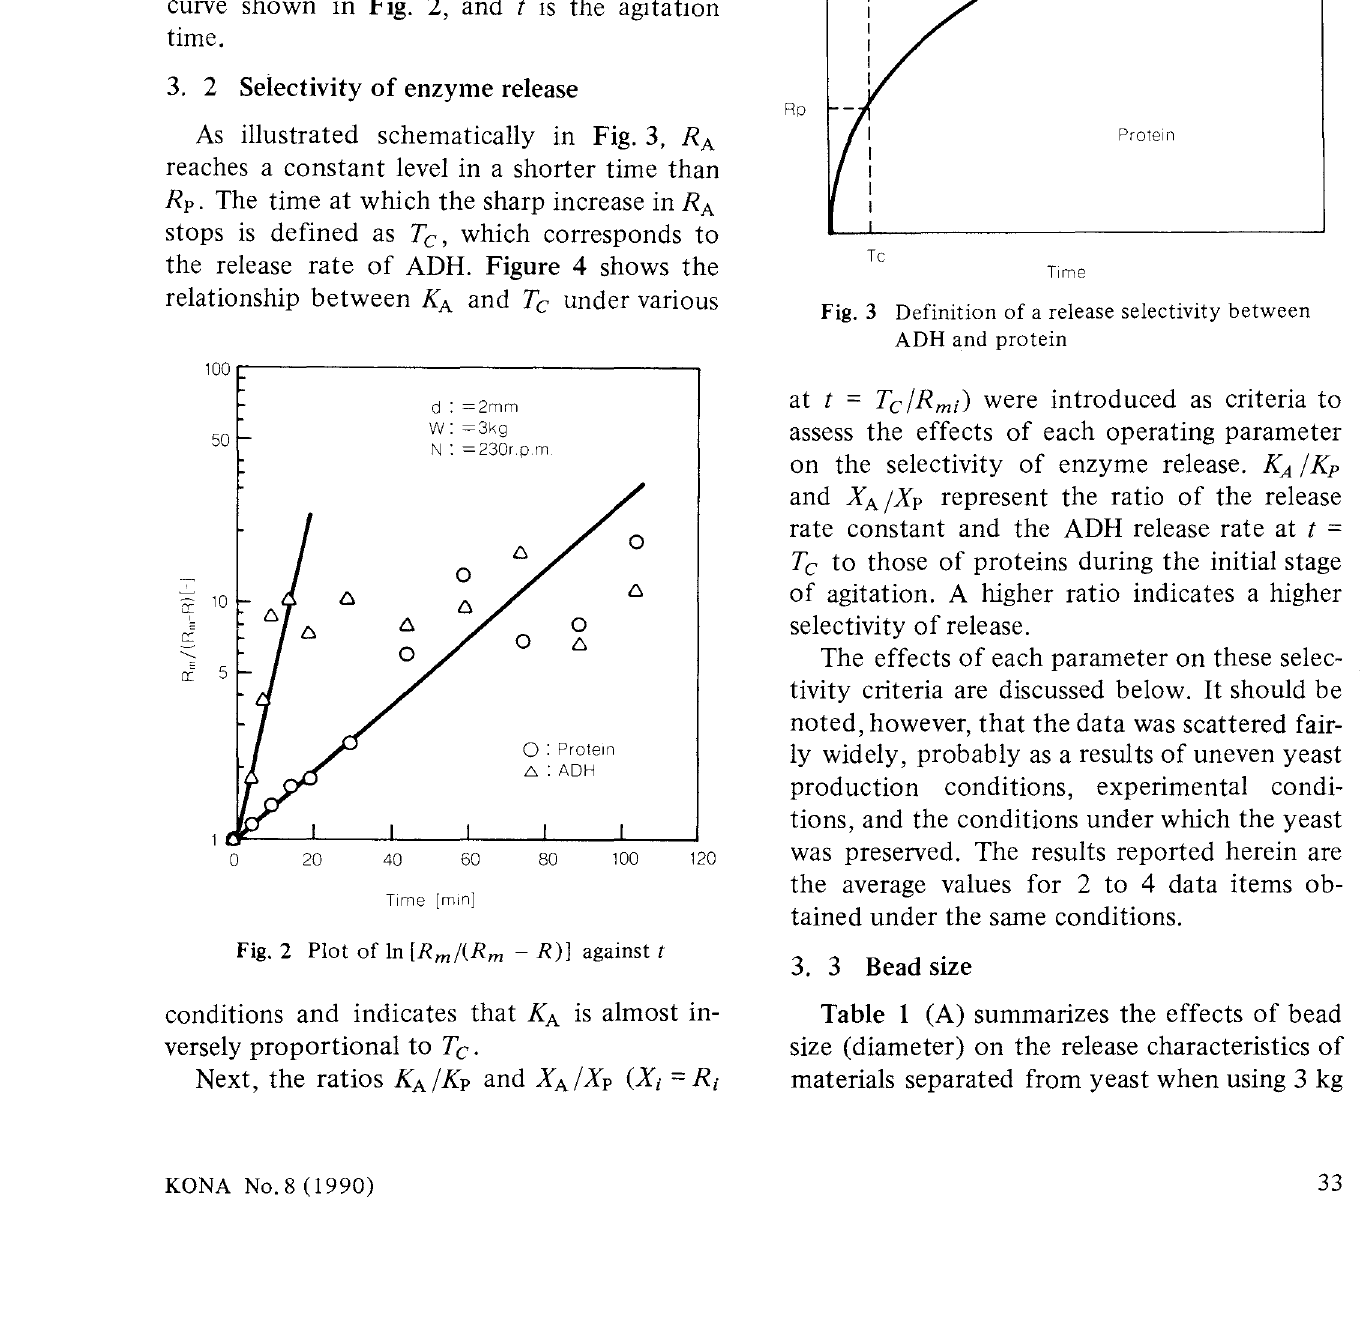
Fig. 2 Plot of In [Rm/(Rm - R)] against t conditions and indicates that KA is almost in versely proportional to Tc.